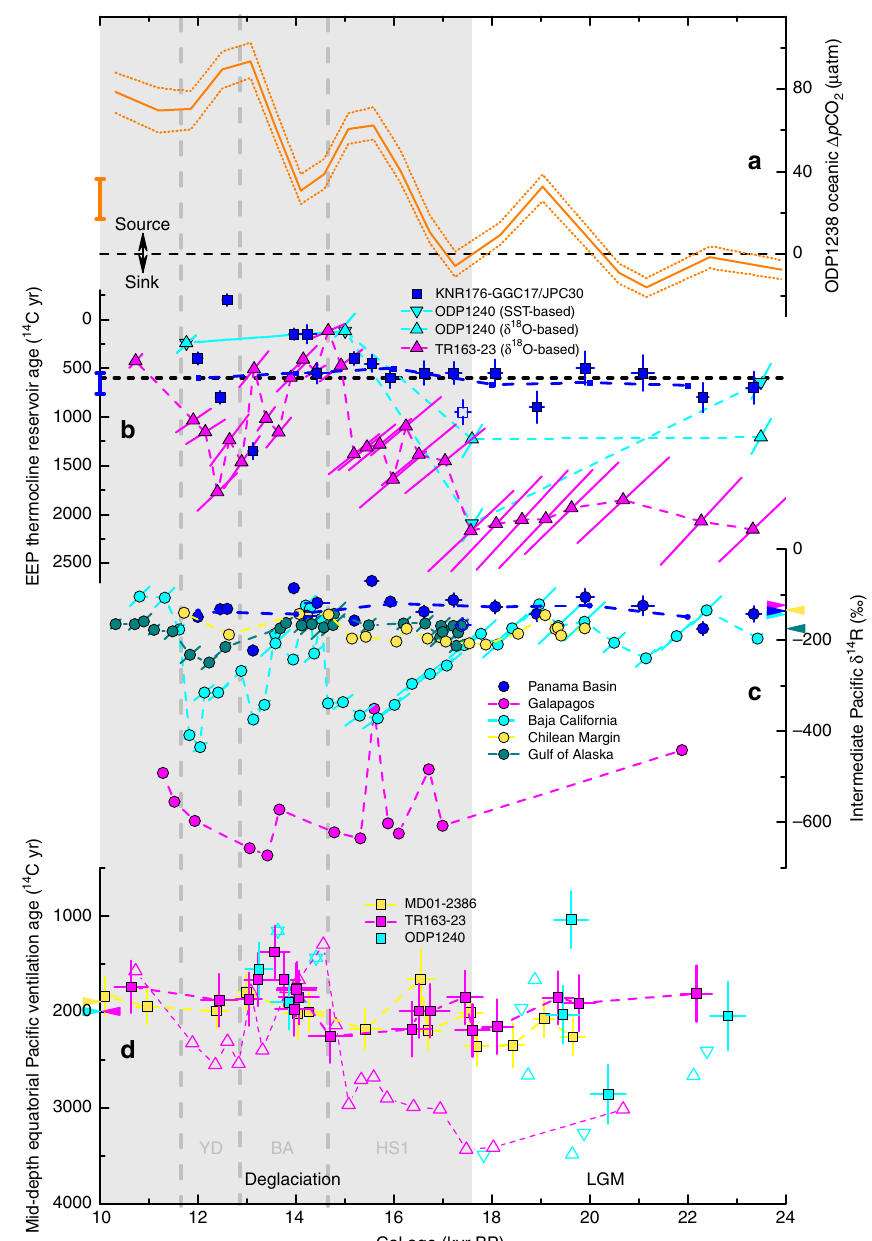
Fig. 3 Glacial − deglacial carbon history of the surface and deep Paci fi c. a Surface oceanic Δ p CO 2 from ODP1238 with envelope showing 1 s.d. uncertainties 10 . Mean mid-late Holocene (after 7 kyr BP) value from the original publication is shown with the orange bar on the left. b EEP thermocline 14 C reservoir ages from KNR176-GGC17/JPC30 based on twig 14 C (blue squares, this study), TR163-23 based on stratigraphic alignments of G. ruber δ 18 O (magenta triangles) 4 , and ODP1240 based on stratigraphic alignments of G. ruber δ 18 O (cyan triangles) and alkenone SST (cyan inverted triangles) 5 . Mean mid-late Holocene value from this study is shown with the blue bar on the left, and the pre-bomb value from GLODAP 23 is displayed as the horizontal black dashed line. c Intermediate (~500 – 1000 m) water 14 C disequilibria from the contemporaneous atmosphere (expressed as δ 14 R) reconstructed from KNR176-GGC17/JPC30 (blue), MV99-MC19/GC31/PC08 (cyan) 13,32 , VM21-30 (magenta) 14 , SO161-SL22 (yellow) 15,37 , and EW0408-85JC (dark cyan) 38 . Where available, the uncertainties of published records are plotted as the major axis of error ellipse. Note that for our new results in b , c , they do not vary with calendar age, and mean values at a 2000-yr step (blue dashed line) are shown to avoid interpretive artifacts imposed by variable resolution. A sample with anomalous δ 13 C and unknown carbon source at ~17.4 kyr BP (Supplementary Fig. 6) is noted with an open symbol. d Mid-depth (~2000 – 3000m) EEP ventilation ages from TR163-23 (magenta square) and ODP1240 (cyan square) reconstructed with a stable reservoir age of N. dutertrei from this study (see Methods). The ventilation ages based on highly variable N. dutertrei reservoir ages derived from stratigraphic alignments 4,5 are displayed with open symbols (with the same colors and shapes as in b ). ODP1240 samples with age reversals 5 are not included. Mid-depth WEP ventilation ages from MD01-2386 are shown in yellow 8 . For c , d , modern value 23 for each site is noted by an arrow with corresponding color on the vertical axis. All error bars in this fi gure represent ±1 s.d. The symbol colors used in Fig. 3 follow those in Fig. 1. YD: Younger Dryas, BA: Bølling-Allerød, HS1: Heinrich Stadial